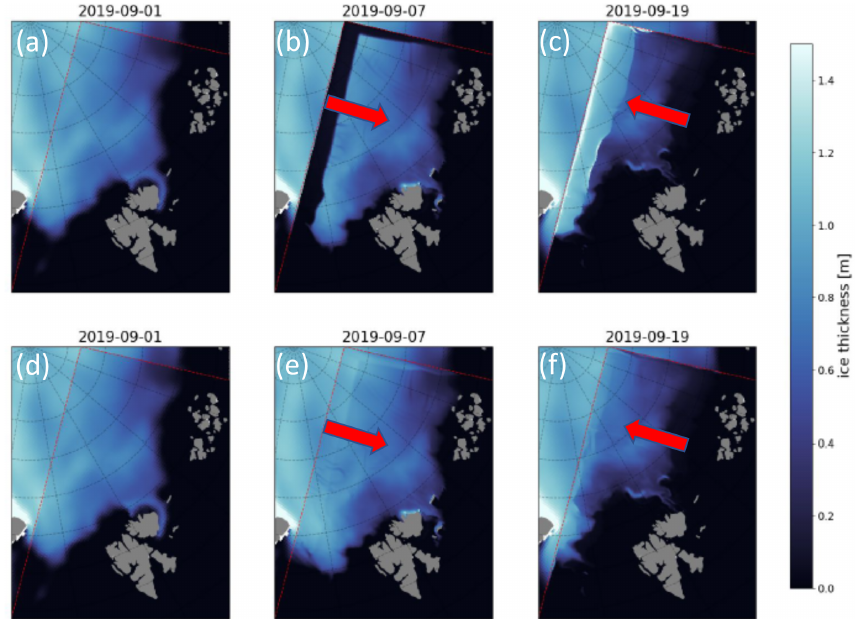
Figure 2. Wind-idealized experiments with the Barents-2.5km model plotted inside the TOPAZ4 model. The Barents-2.5km model was run in its full state except the wind forcing was idealized in the sense of constant wind in the model xi direction. The figure shows sea ice thickness fields at three moments in time for the run without (a–c) and with (d–f) time-varying boundaries. The first column is the initial TOPAZ4 field interpolated onto the Barents-2.5km grid, the second column corresponds to Barents-2.5km results after 6d as the wind turns back in the negative direction, i.e., when the sea ice should be at its maximum displacement relative to the left-most boundary, and the final column shows the state towards the very end of the run when the wind has been blowing “left” for 12d. Wind direction is shown by the red